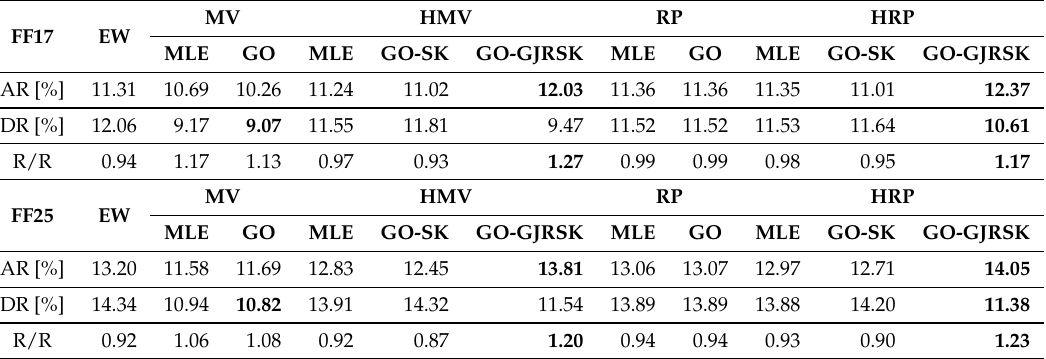
Table 2. AR, DR, and R/R for an EW, MV, RP, HMV, and HRP portfolios using three methods. In the rows labeled AR, DR, and R/R, the best results appear in bold for MV, HMV portfolios, and RP, HRP